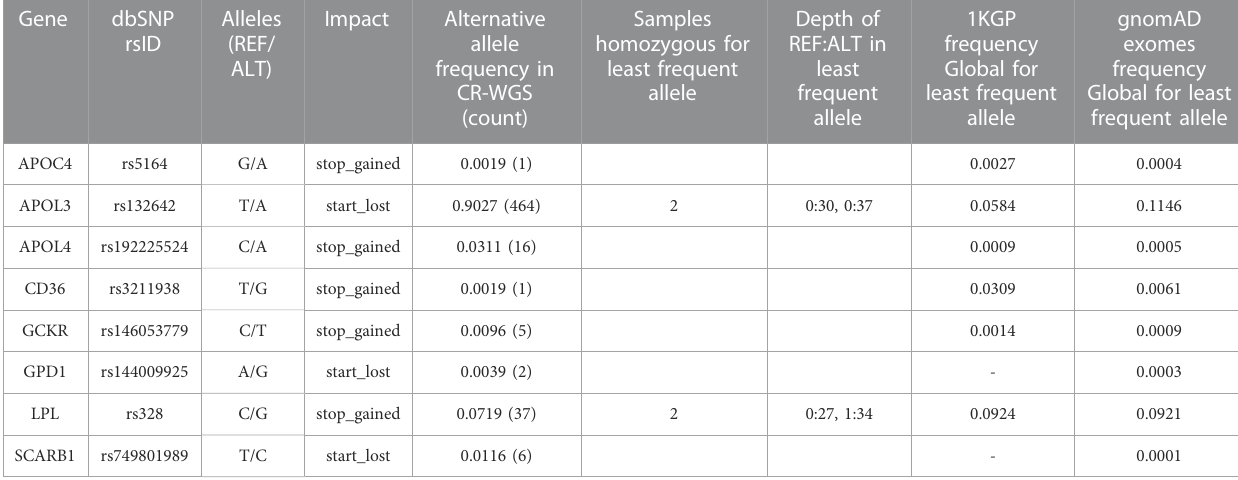
TABLE 3 High-risk variants frequency and presence of homozygous individuals for the alternate allele in CR-WGS.